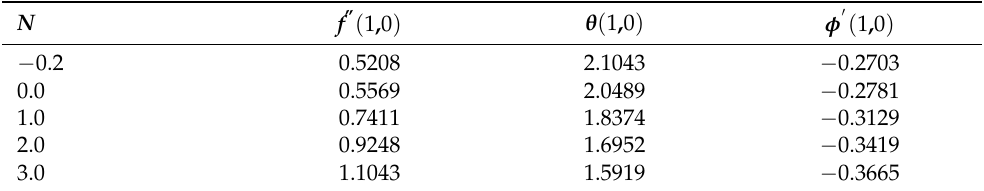
Table 4. Solutions of f (cid:48)(cid:48) ( 1,0 ) , θ ( 1,0 ) , and φ (cid:48) ( 1,0 ) for various values of N at n = 1.0, Sc = 1.0, γ = 2.01,